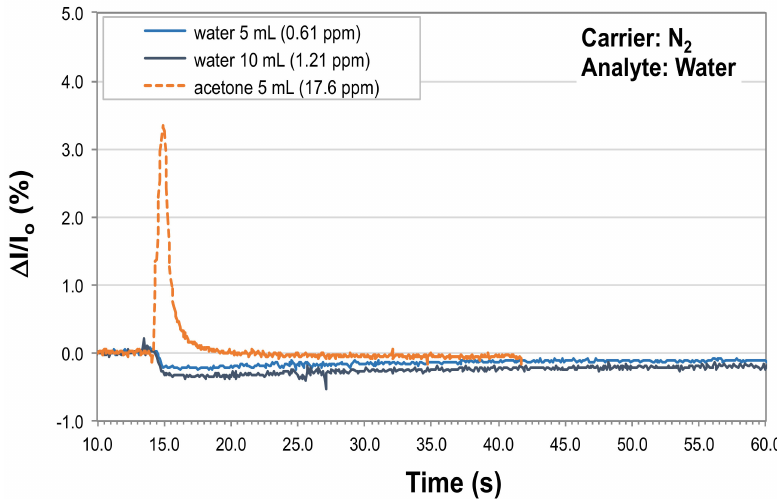
Figure 6. P3HT NF-sensor response to injections of 5 mL (cyan curve) and 10 mL (dark grey curve) of water vapor saturated at 25 ◦ C, using nitrogen as the carrier gas and the same experimental conditions (carrier flow rate, temperature and ambient pressure) used along tests carried out to measure in-flow acetone response of P3HT NF sensing elements. The orange dashed curve represents the response of the sensing element to 5 mL of acetone. In the inset: magnification of the response of the sensing element to 5 and 10 mL of water vapor (cyan and dark grey curve,